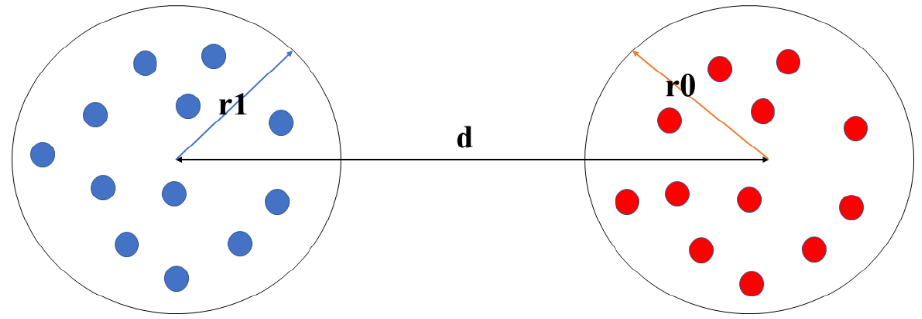
Figure 4. Clusters in an ideal kernel space.